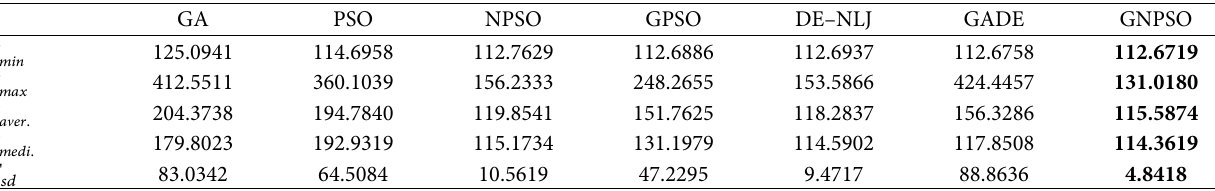
The bold values mean the best values among all the algorithms.